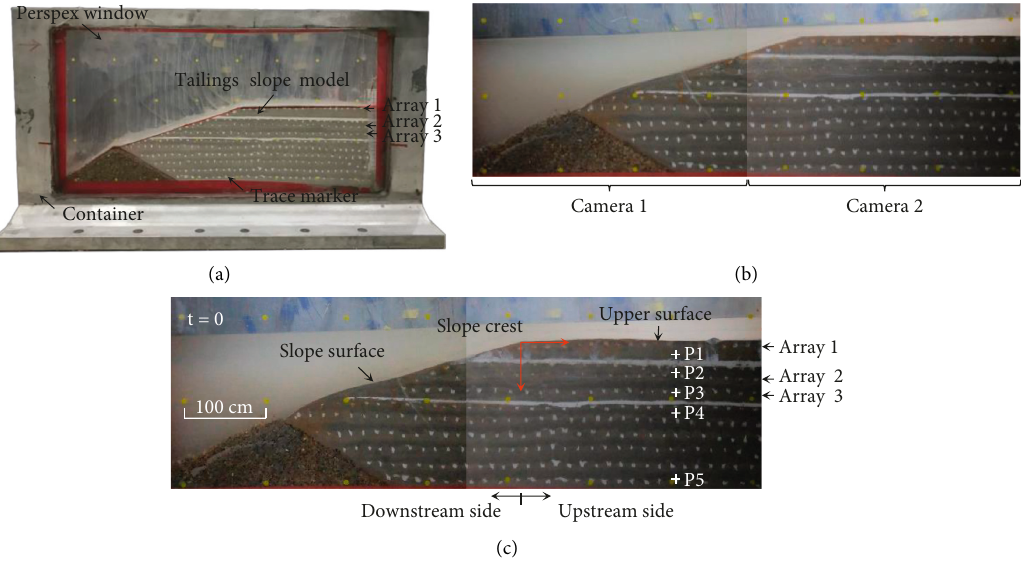
Figure 3: Pictures of the model used in test T 3 taken: (a) after the construction of the dry sample, (b) before spin-up of the centrifuge, and (c) before shaking at